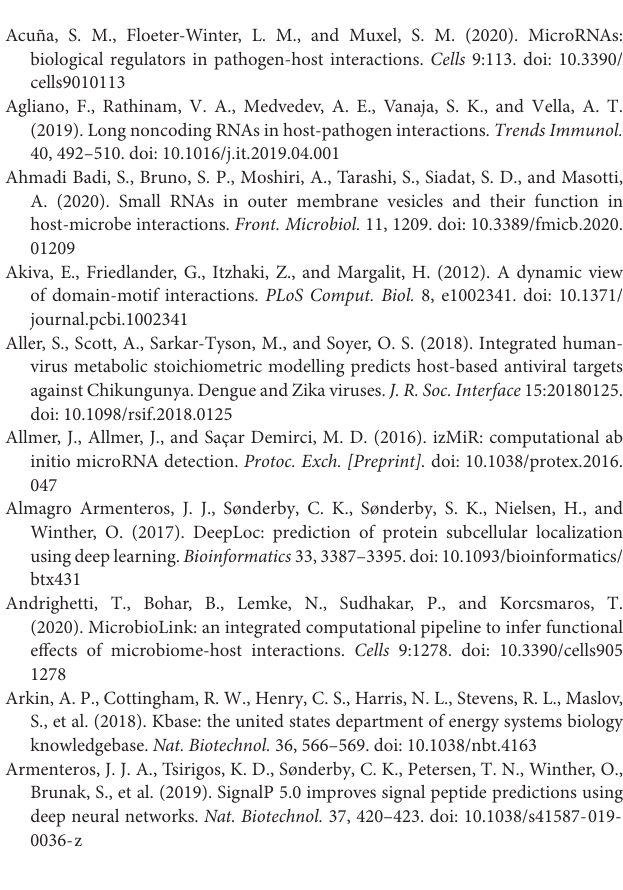
Supplementary Table 1 | Studies using genome-scale metabolic models and constraint based approaches to infer mechanistic co-metabolic interactions between microbial and host